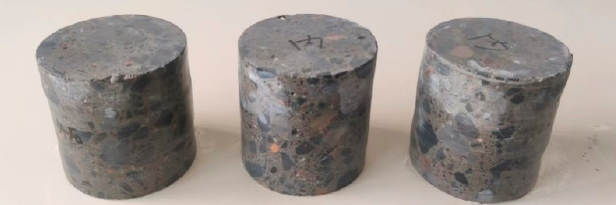
Figure 2. Specimens for the compressive strength of concrete. Table 2. Material properties of test PCCP.